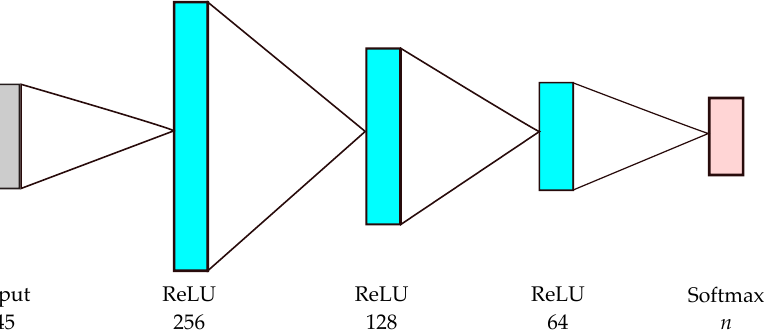
Figure 2. The architecture of the feed forward neural network used for bird classification. The input x ∈ R 45 maps through three intermediate layers with d 1 = 256, d 2 = 128, and d 3 = 64 and ReLU transfer functions. The output layer maps to n independent classes with a softmax transfer function where n is the number of bird